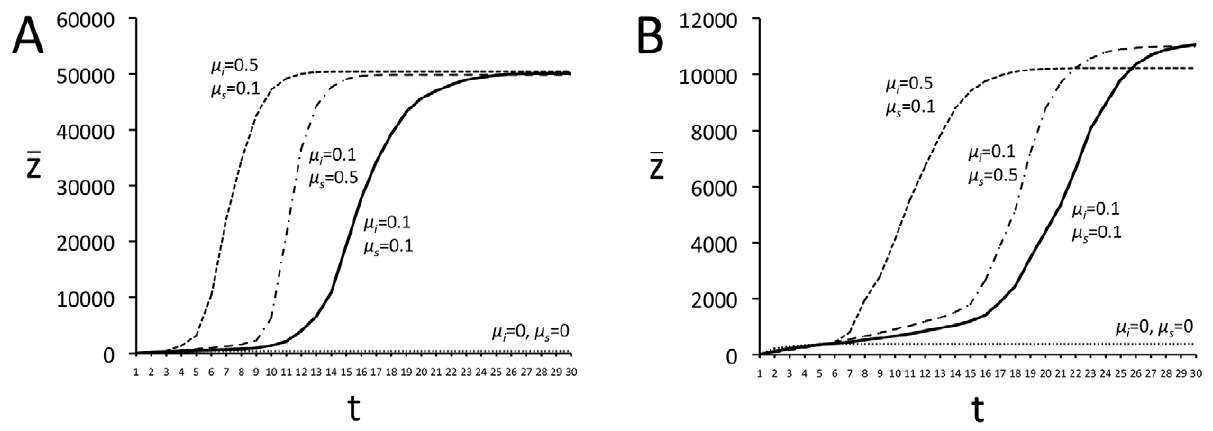
Figure 7. Time series of mean cultural complexity Z when c i and c s decrease in proportion to Z according to proportionality constants m i and m s respectively. In (A) transmission is directly biased, in (B) transmission is indirectly biased. Other parameters: N =100, c i =200, c s =100, l =1000, all results are the average of 100 independent runs.